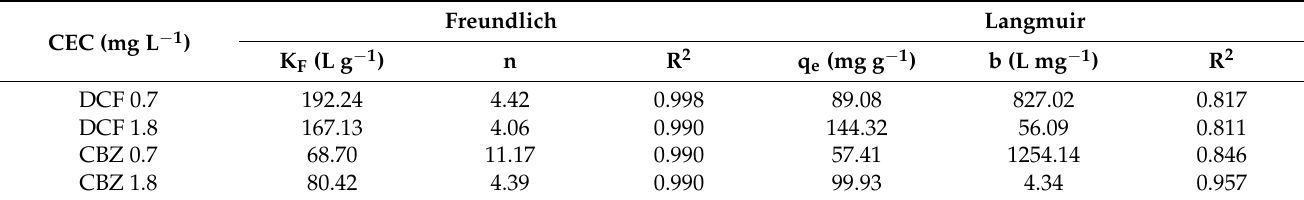
Table 2. Freundlich and Langmuir Isotherm parameters for DCF and